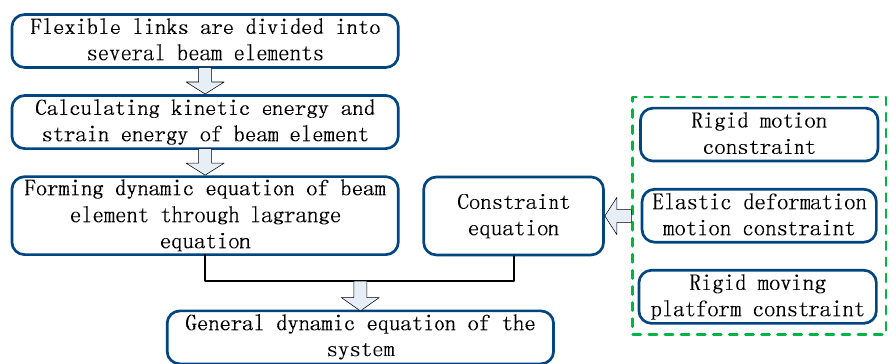
Figure 1. Modeling process of the 3-DOF flexible parallel robot mechanism.